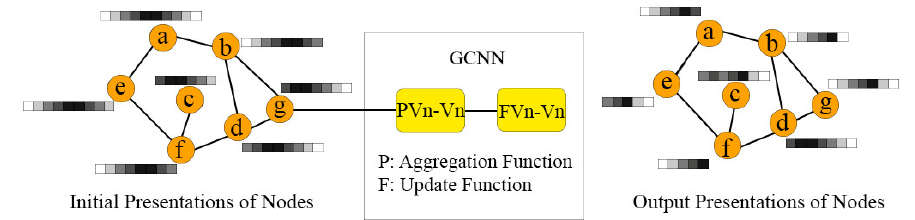
Figure 1. A GCNN architecture diagram with node presentations.